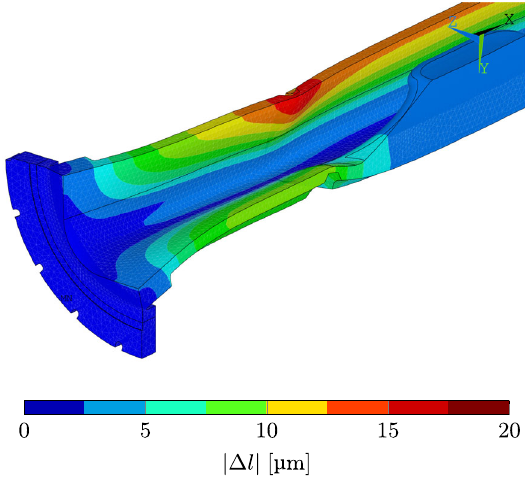
FIG. 19. Deformation Δ l due to a quasistatic pressure differ- ence at the cavity walls of 1 bar as simulated in APDL . Both flanges are fixed in position and symmetry is applied in the transverse directions. Gravity is not